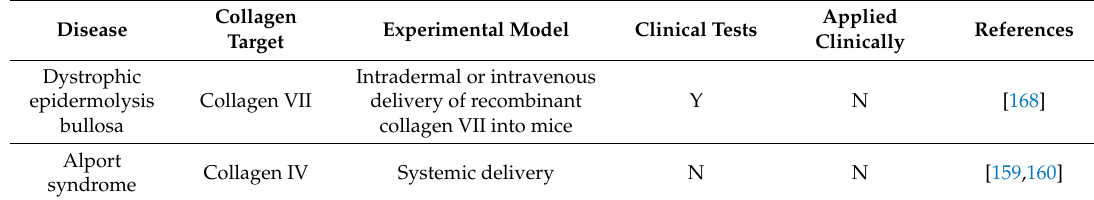
Table 3. Experimental protein replacement therapies with the use of recombinant collagens. Collagen Disease